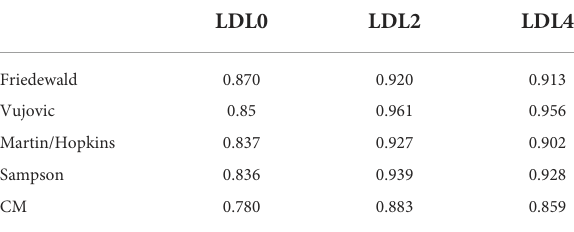
TABLE 2 Correlation in chemical masking method measured and formula estimated vs. VAP measured LDL-C. LDL0 LDL2